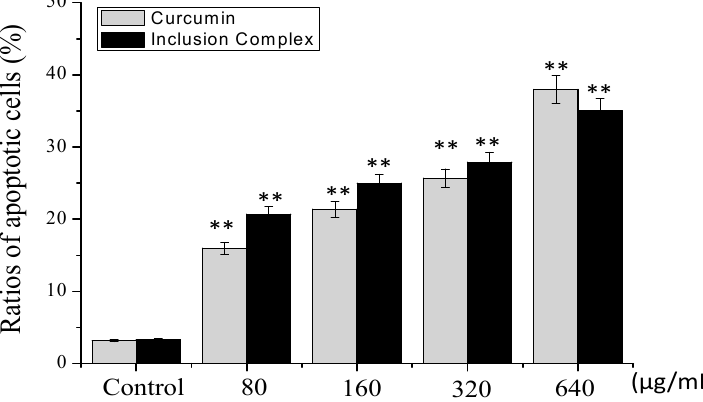
Figure 8. Flow cytometric analysis of A375 cells treated with inclusion complex by Annexin V/PI staining assay. p < 0.01 (**) vs. control group.